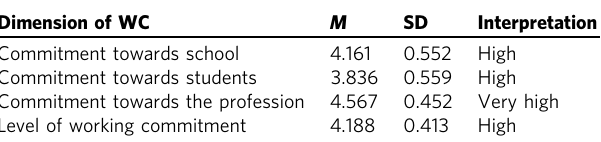
Table 8 The means and standard deviations for WC items.